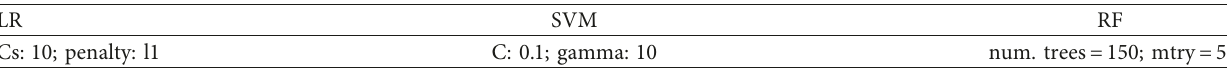
Table 16: For quoting interactions from April 12 until April 22 in 2021, utilizing the obtained similarities between nodes, best hyper- parameters for LR, SVM, and RF models. LR